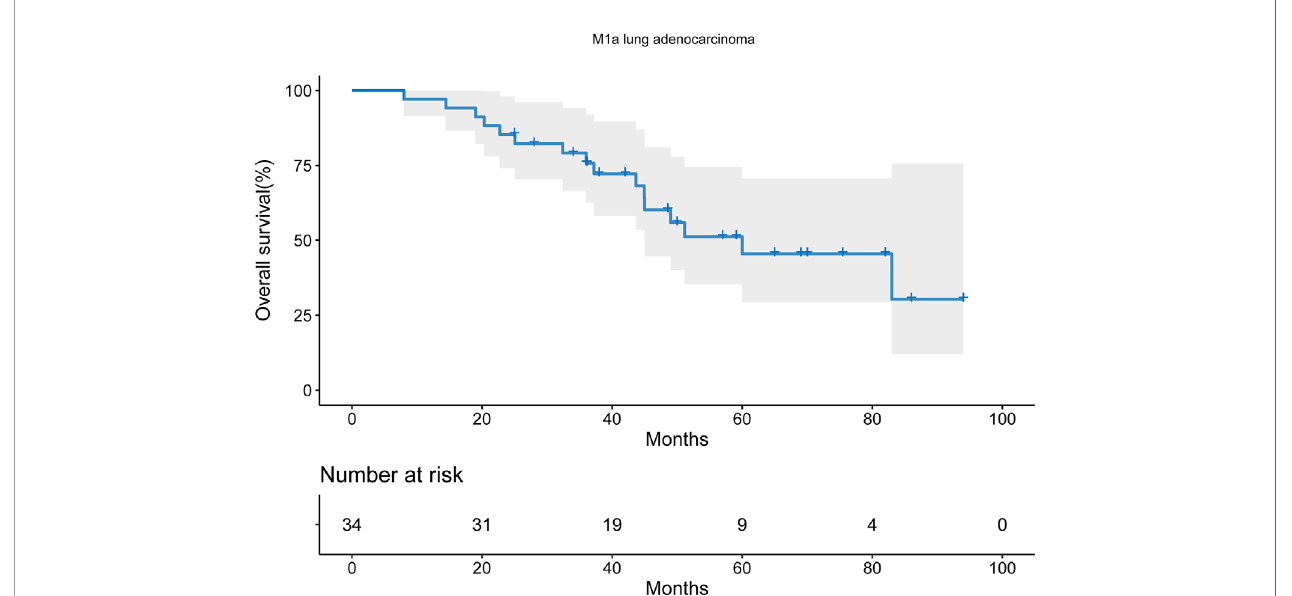
FIGURE 1 | Overall survival of M1a lung adenocarcinoma patients receiving targeted therapy.